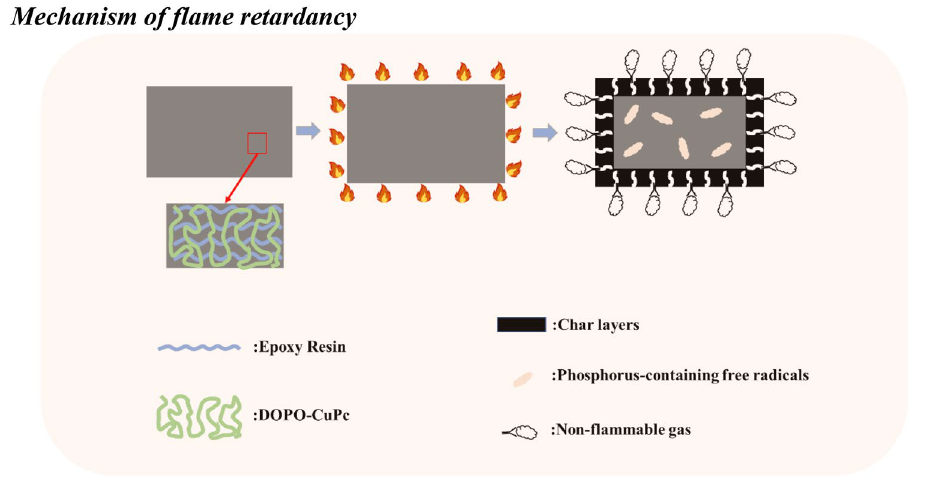
Scheme 2. Flame retardant mechanism of DOPO-CuPc.